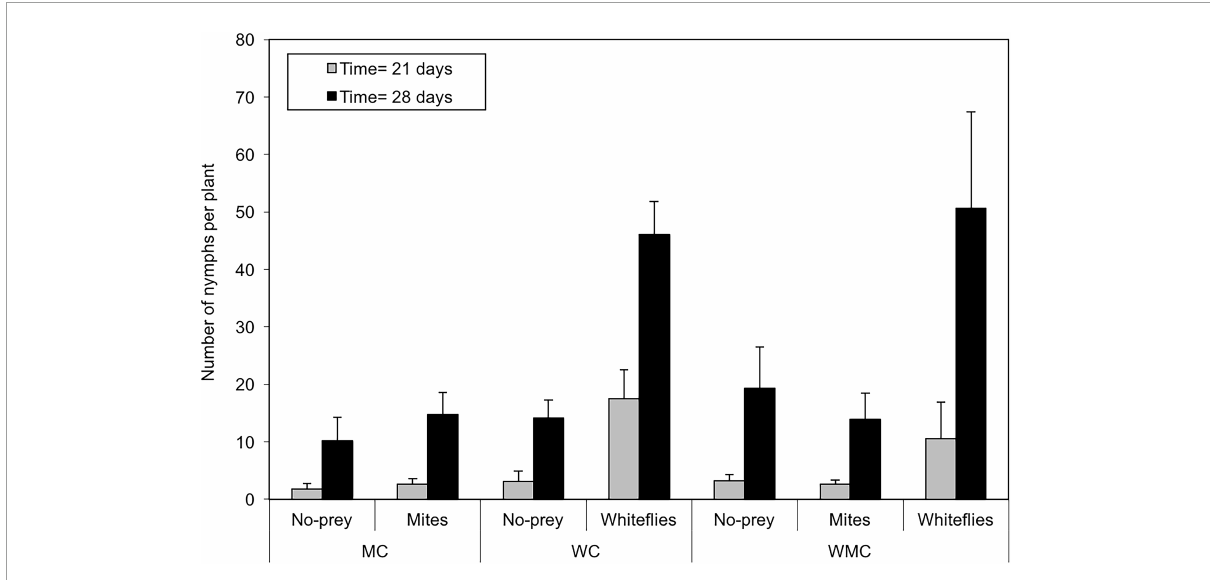
FIGURE2 Fitness of D. hesperus females (offspring per female) vs. the number of females per plant as observed in the third and fourth weeks since the introduction of tomato plants in the glasshouses).